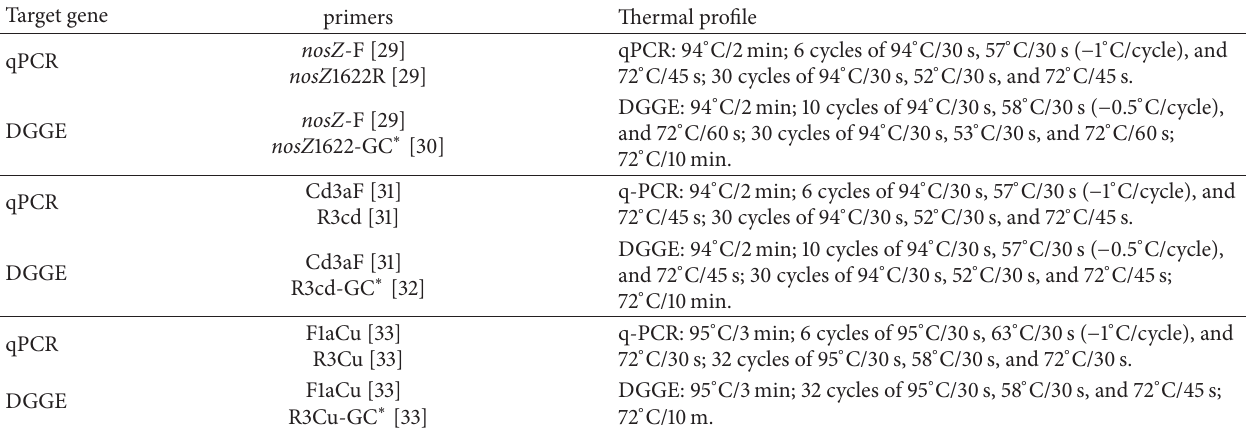
Table 2: Primers and thermal profiles used for the qPCR and